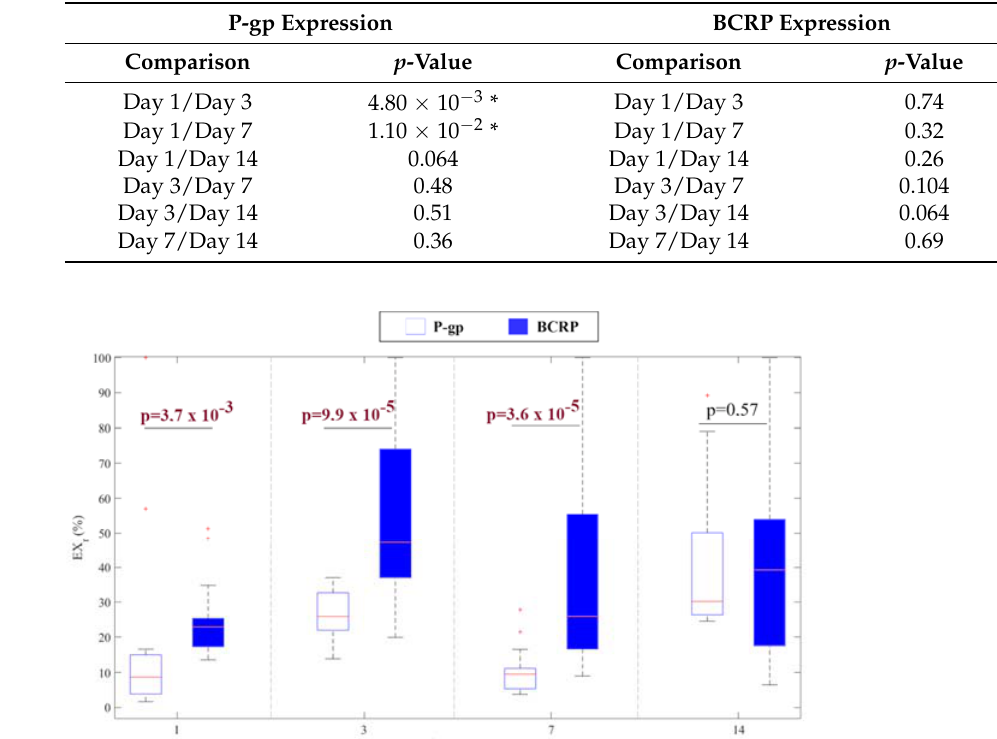
Figure 3. Boxplots of both P-gp and BCRP expressions in the sonicated regions normalized to the expressions in the contralateral ROIs evaluated at different time points within two weeks after FUS application.